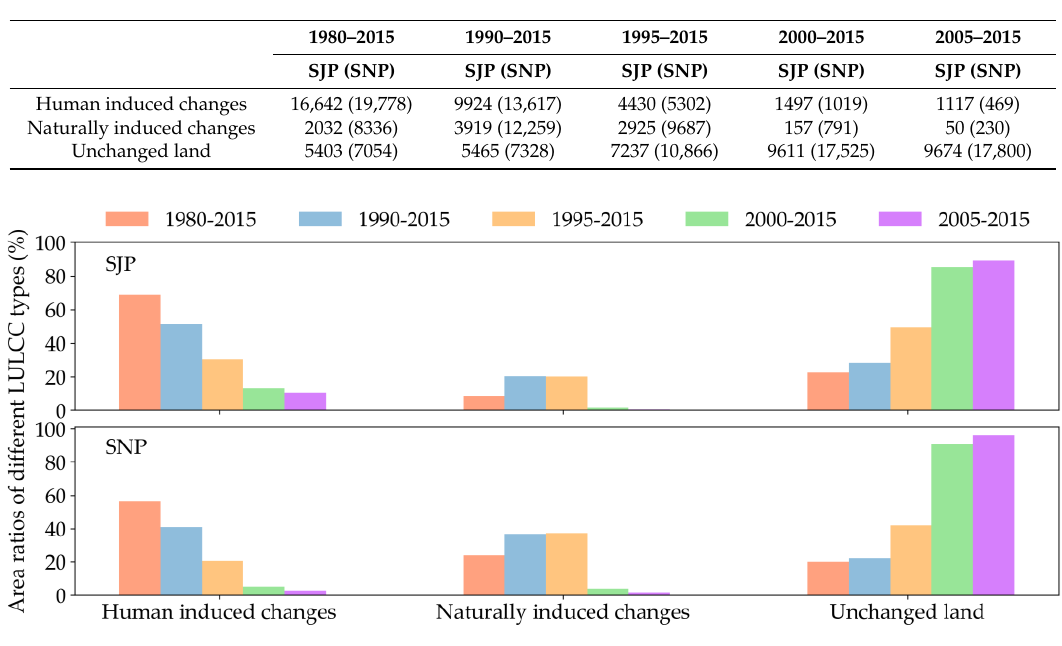
Table 6. Areas simulated in the five different periods for three types of LULCC (km 2 ).